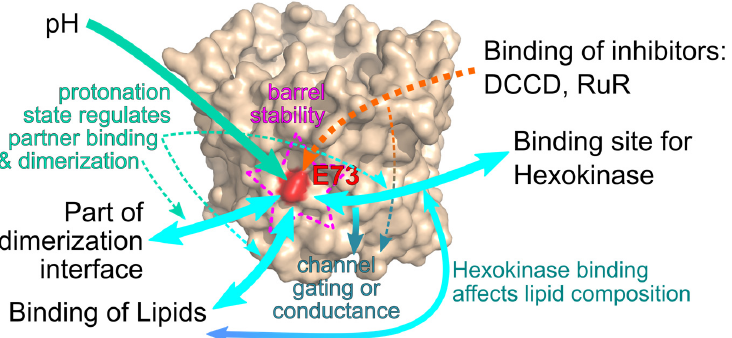
Figure 3. Interactions at E73. Multiple interactions of molecular partners were described for E73. The charge at E73 renders the protein more flexible to allow ions and binding partners to access E73 (magenta). The protonation state of E73 is affected by the intracelullar pH (green) and influences channel dimerization and the binding of lipids and hexokinase to the channel (light blue). These interactions affect channel gating and conduction but could also influence each other, for example through a hexokinase induced change in membrane lipid composition. Synthetic channel modifiers such as RuR or DCCD also bind to E73 and directly affect channel gating and conductance